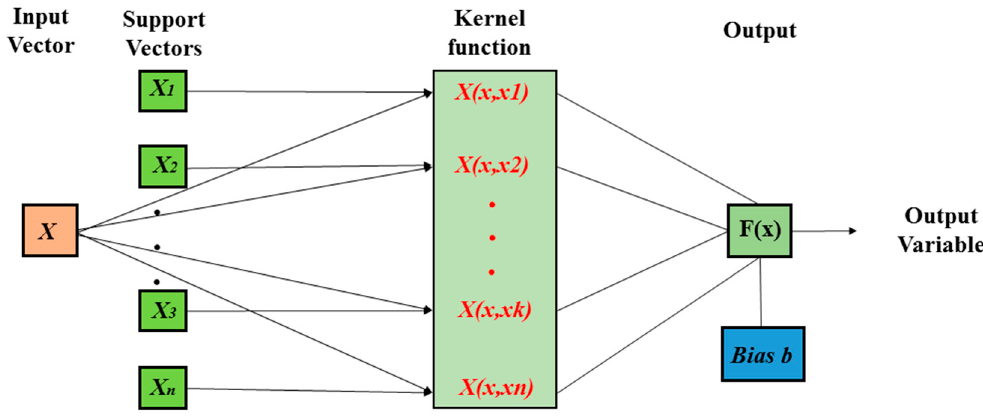
Figure 4. Support vector regression structure including input variables and output variable.